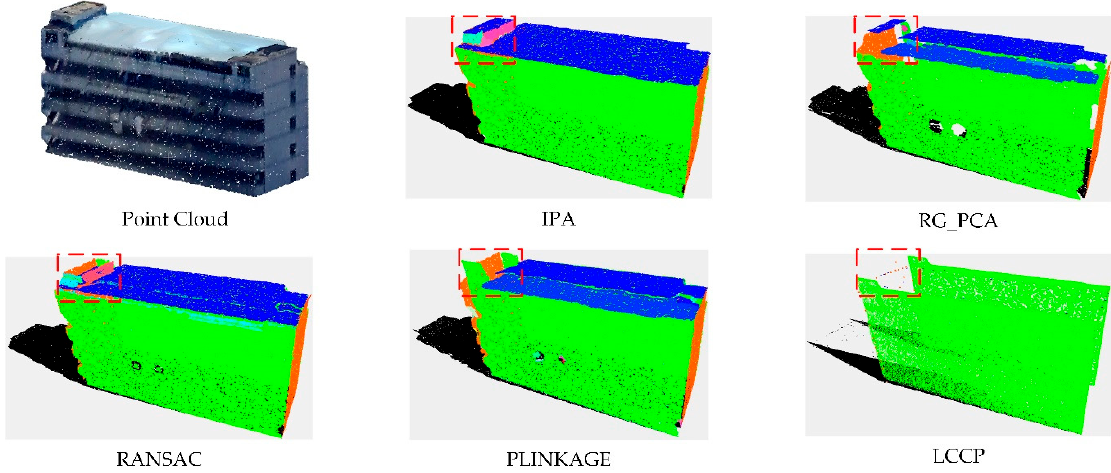
Figure 11. Comparison of the planar abstraction quality of building 1.